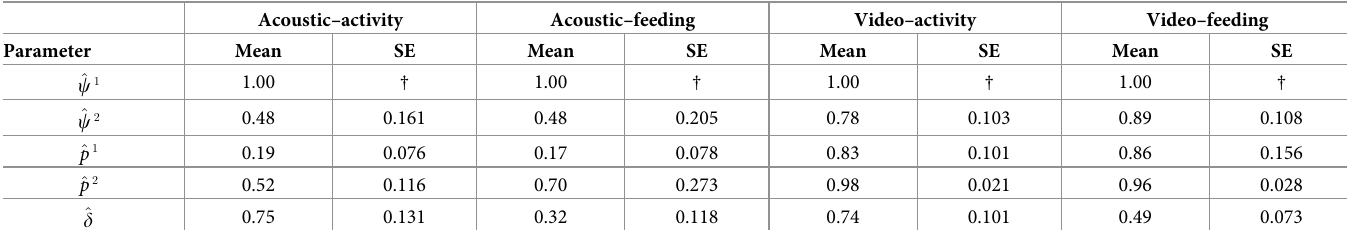
Table 1. Null model parameter estimates for each of four model